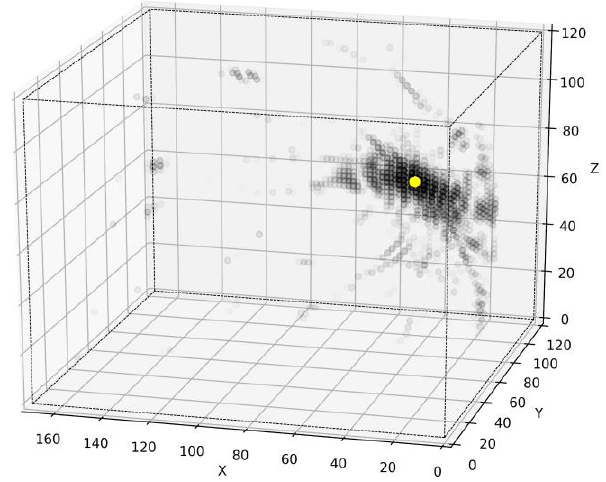
Figure 6. Target localization result using the probability-based ToF method.